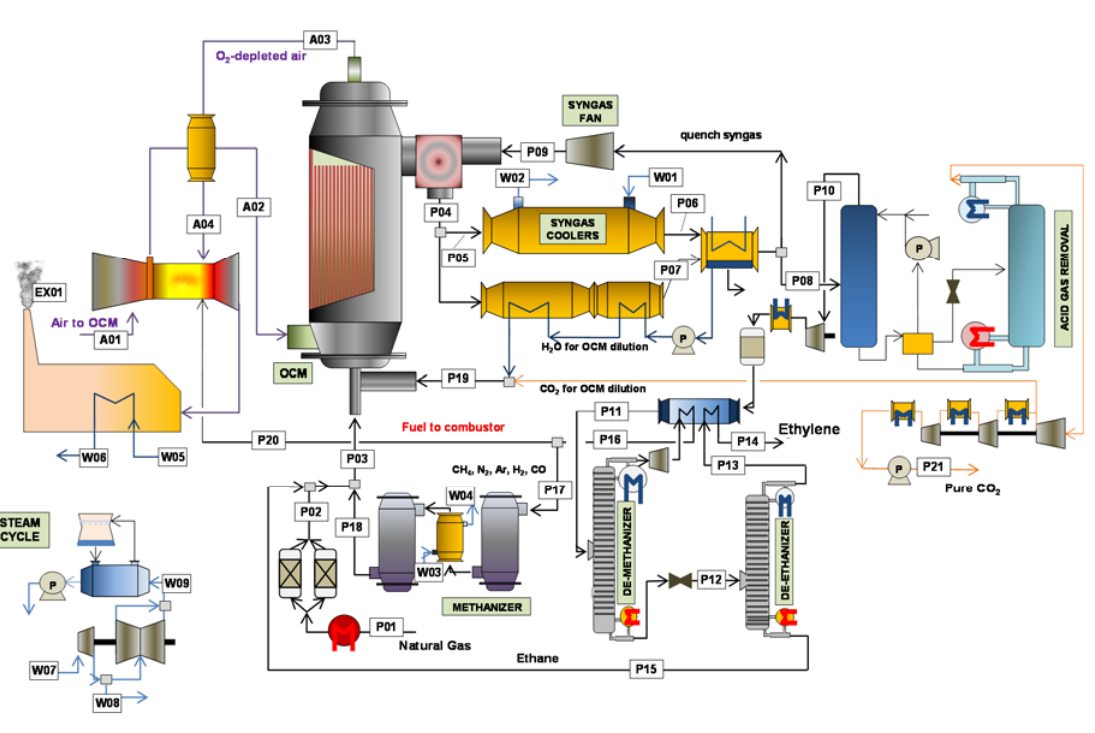
Figure 1. Dense membrane reactor OCM process flow diagram.